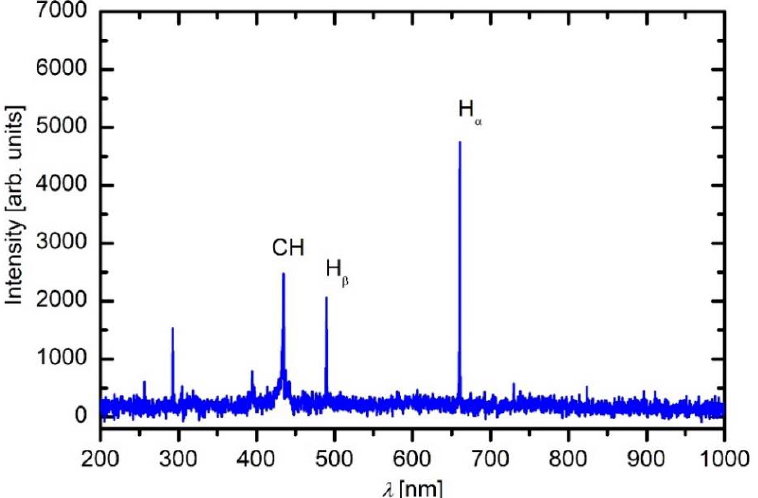
Figure 3. An optical spectrum of the plasma at the discharge power of 5 kW and 130 sccm of HMDSO.